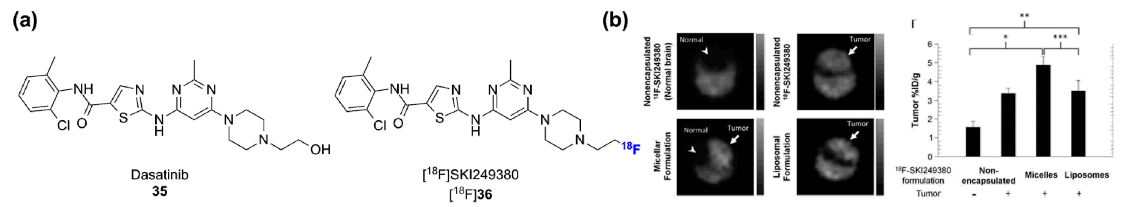
Figure 11. ( a ) Chemical structure of dasatinib and [ 18 F]SKI249380 (deoxy-[ 18 F]fluoro-dasatinib); ( b ) Axial PET images representing the brain uptake for different nanoformulations of [ 18 F]SKI249380 in a PDGFR-driven mouse model of high grade glioma. * p = 0.002, ** p = 0.014, *** p = 0.016. (reprinted from [132], with permission from Elsevier).